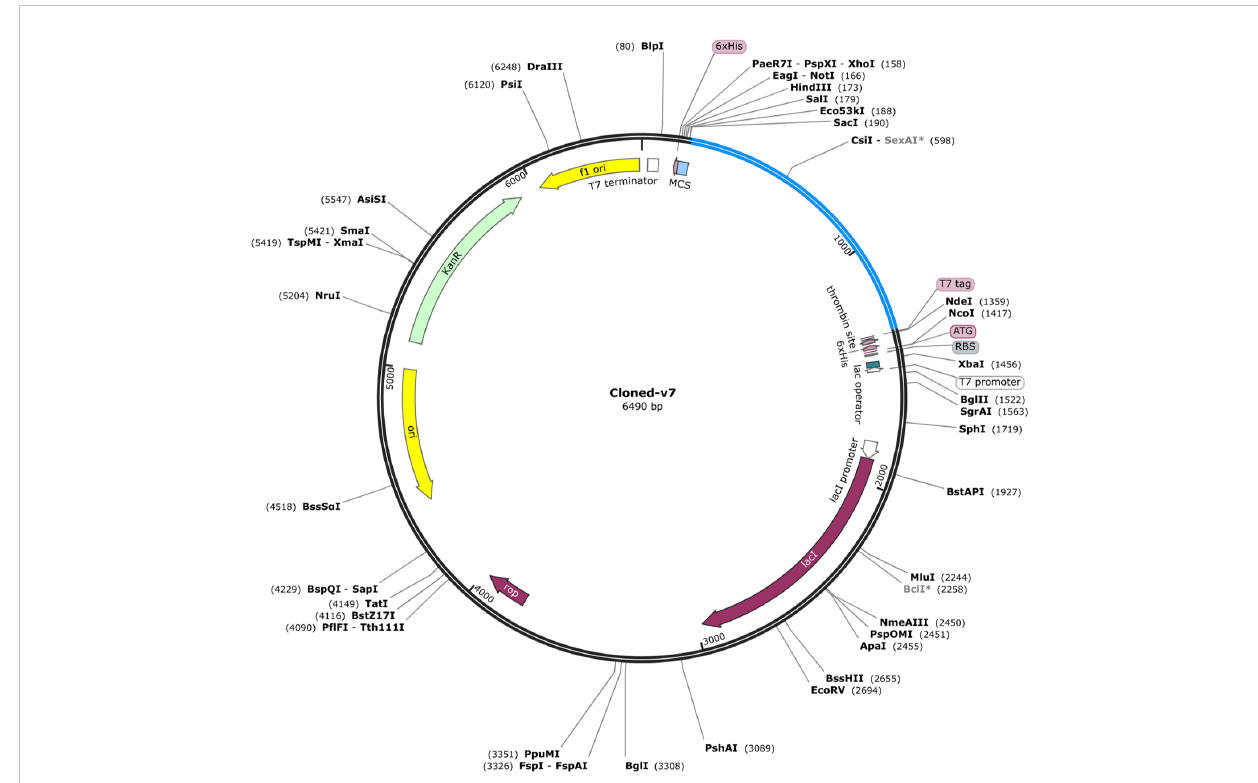
FIGURE 5 In-silico restriction cloning of fi nal vaccine construct (V7) into the E. coli pET28a (+) expression vector where red color shows the cloned vaccine